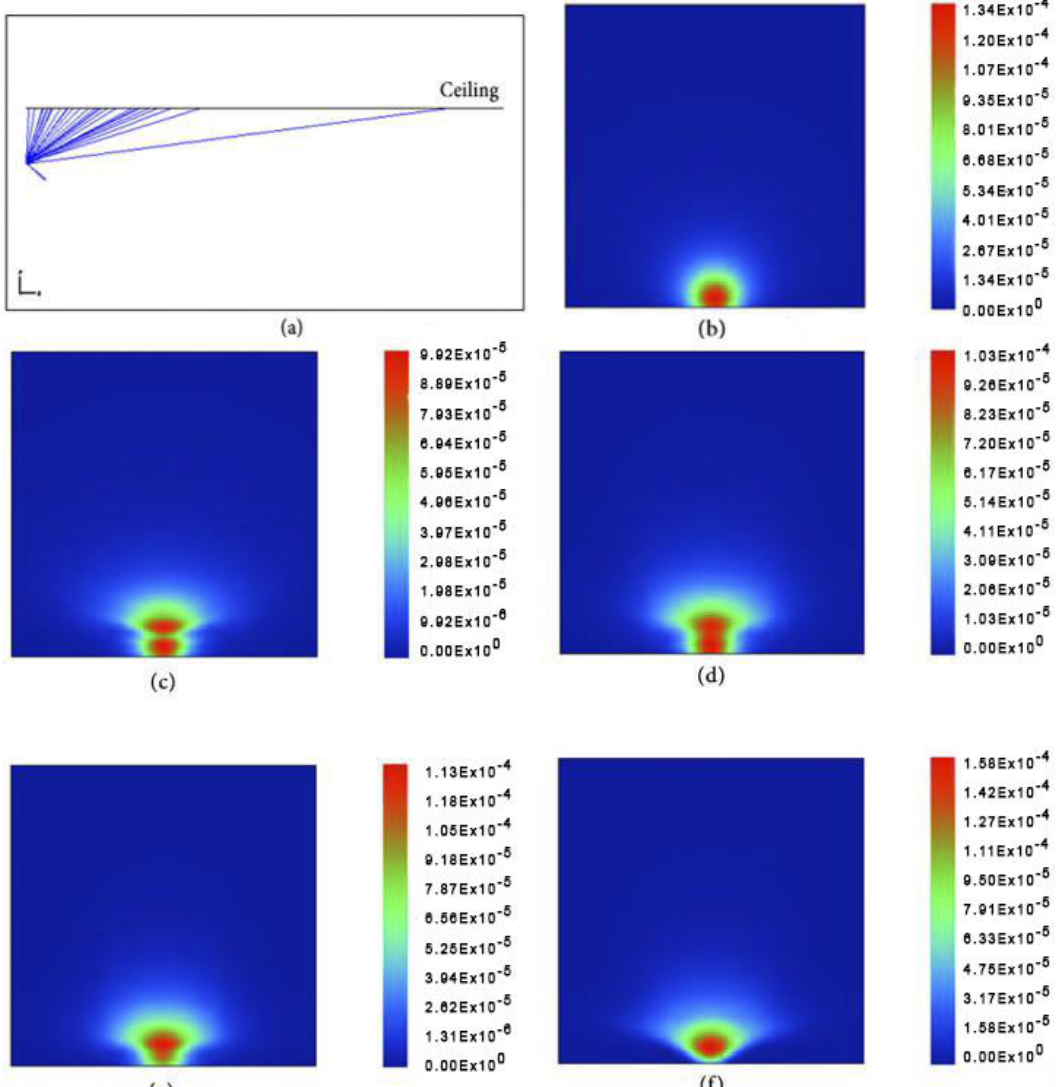
Figure 3. Light distribution on the ceiling with the set up ( a ) at distance of d = 40 cm of ( b ) no lens; ( c ) B1; ( d ) B2; ( e ) B3; ( f )